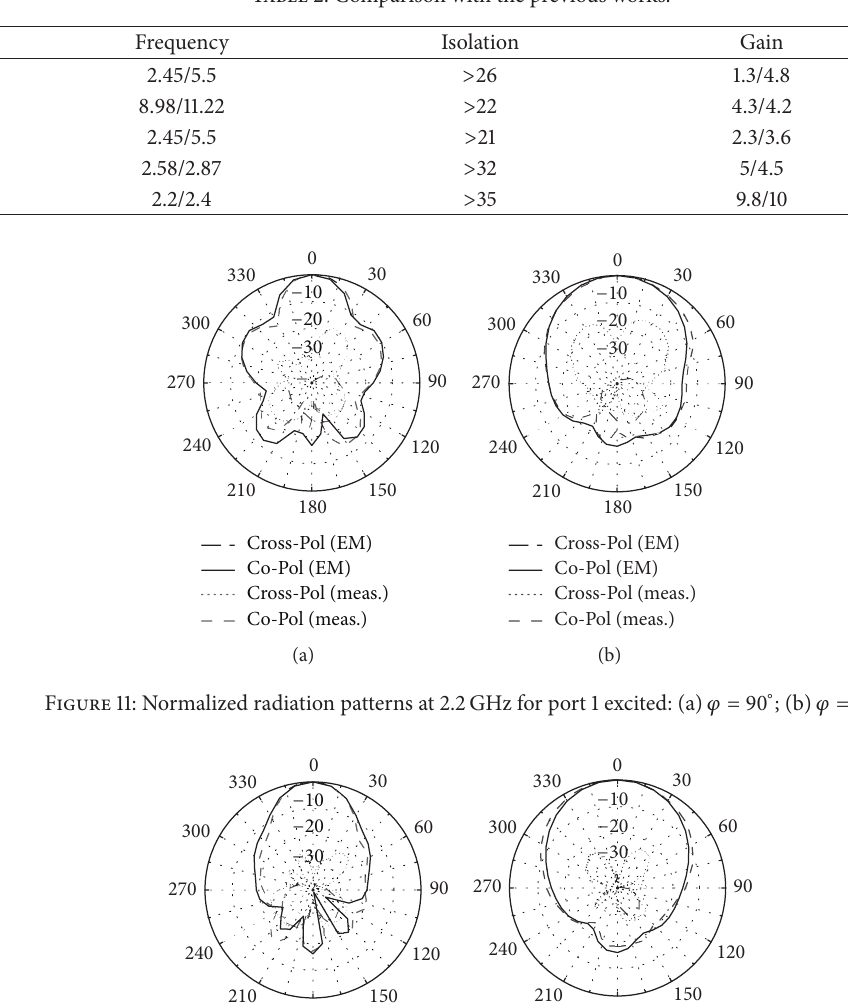
Table 2: Comparison with the previous works.